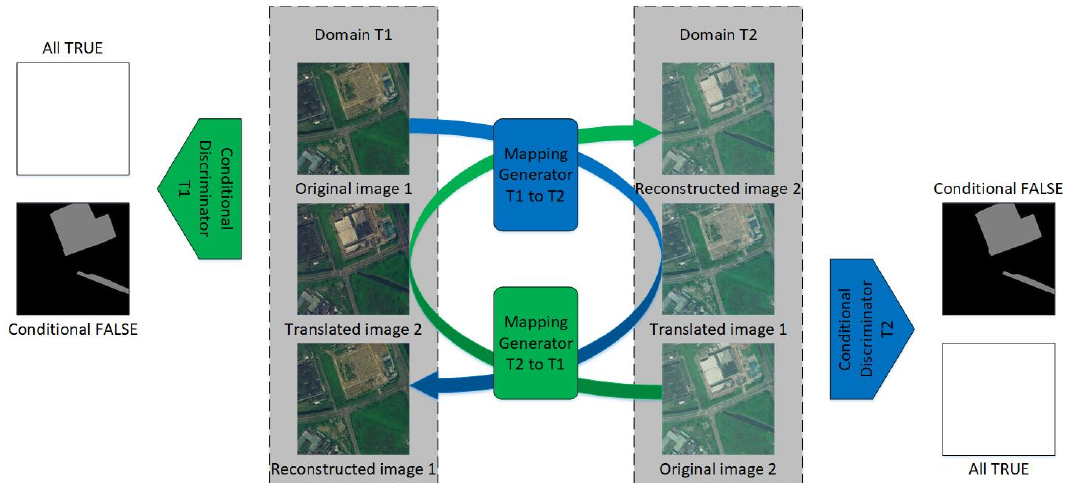
Figure 2. Dataflow of the domain transfer stream. The values of white and black pixels are 1 and 0, and the values of gray pixels are random between 0 and 1.